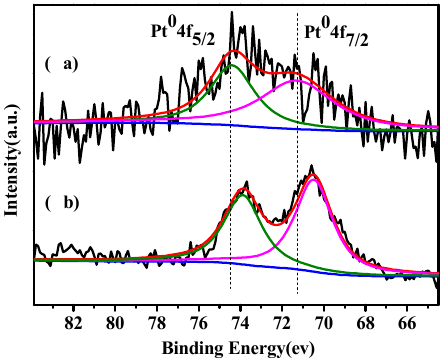
Figure 3. FT-IR spectra of Pt 0.5 /SiO 2 before ( a ) and after reaction ( b ), as well as Pt 0.5 /SiO 2 -Shiff before ( c ) and after reaction ( d ).